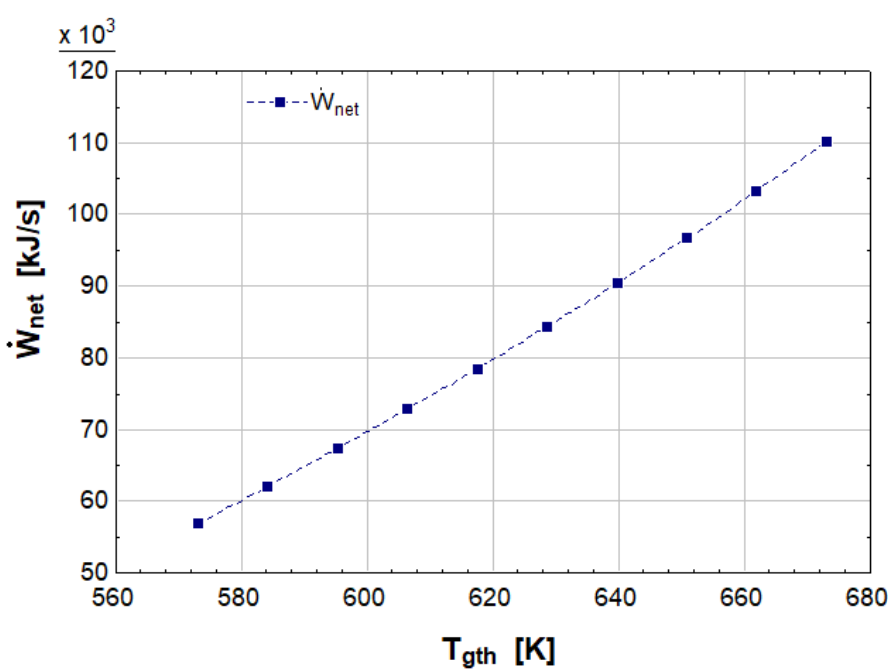
Figure 4. Effect of Geothermal Source Temperature on Net Power Output of System.